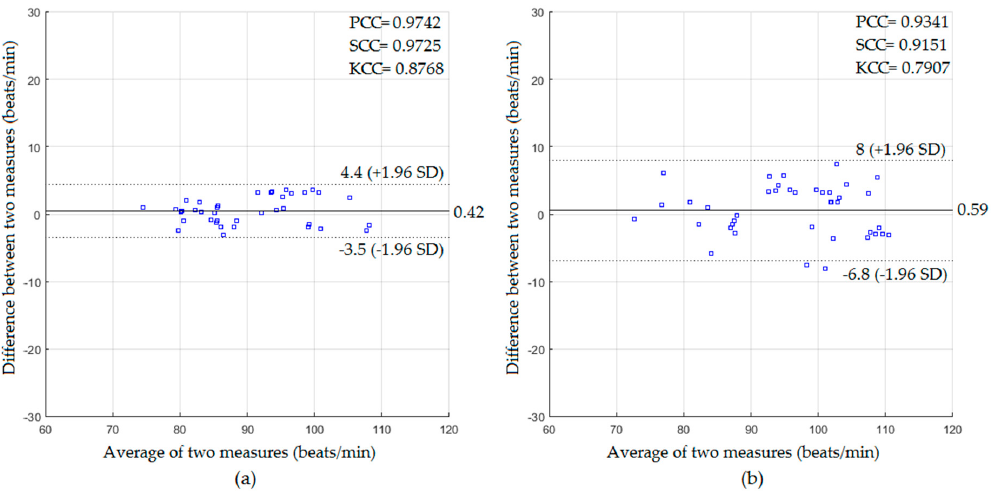
Figure 7. The statistics of HR measurements obtained in a dark environment for participants ( a ) without a blanket; ( b ) with a blanket.